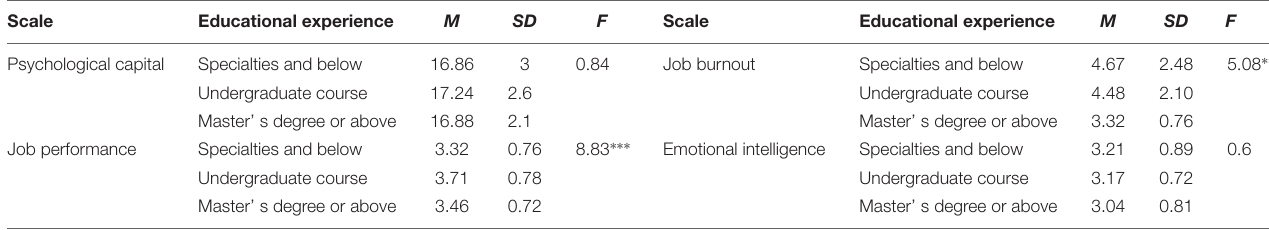
TABLE 7 | One-way ANOVA analysis of all scales in educational experience.